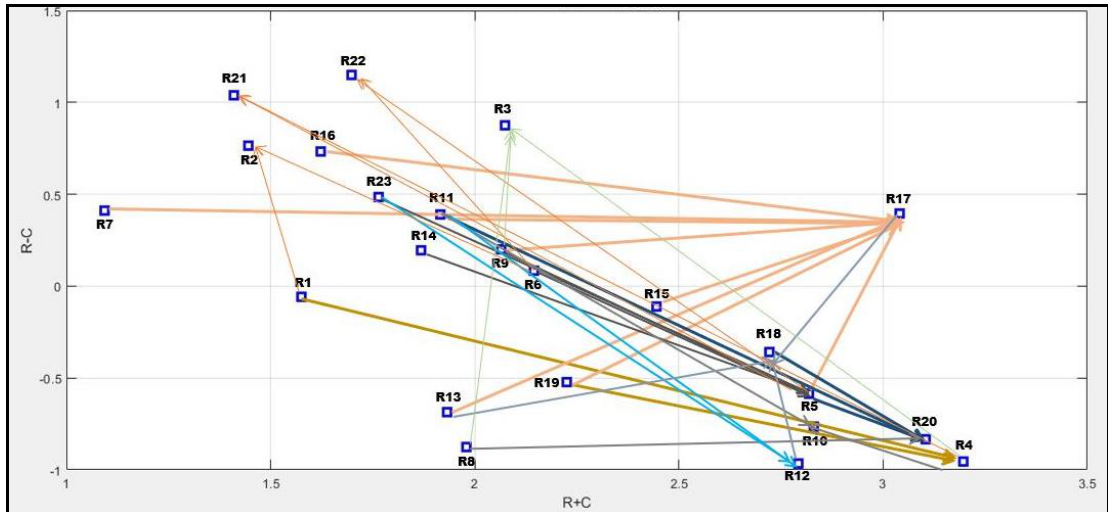
Figure 2. Risk interdependence graph.